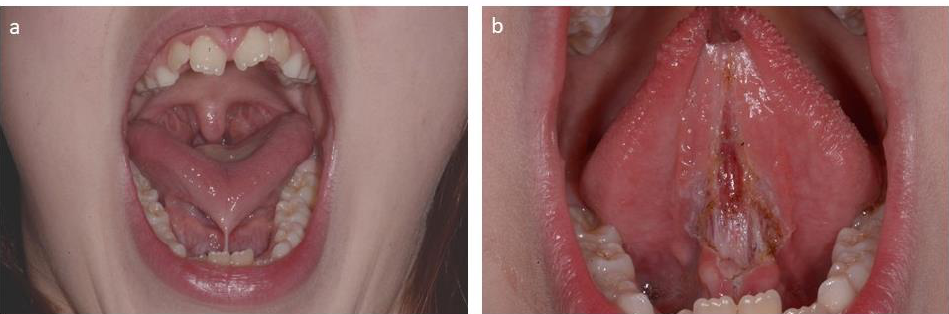
Figure 2. Clinical evaluation: ( a ) (preoperative), ( b ) (postoperative).